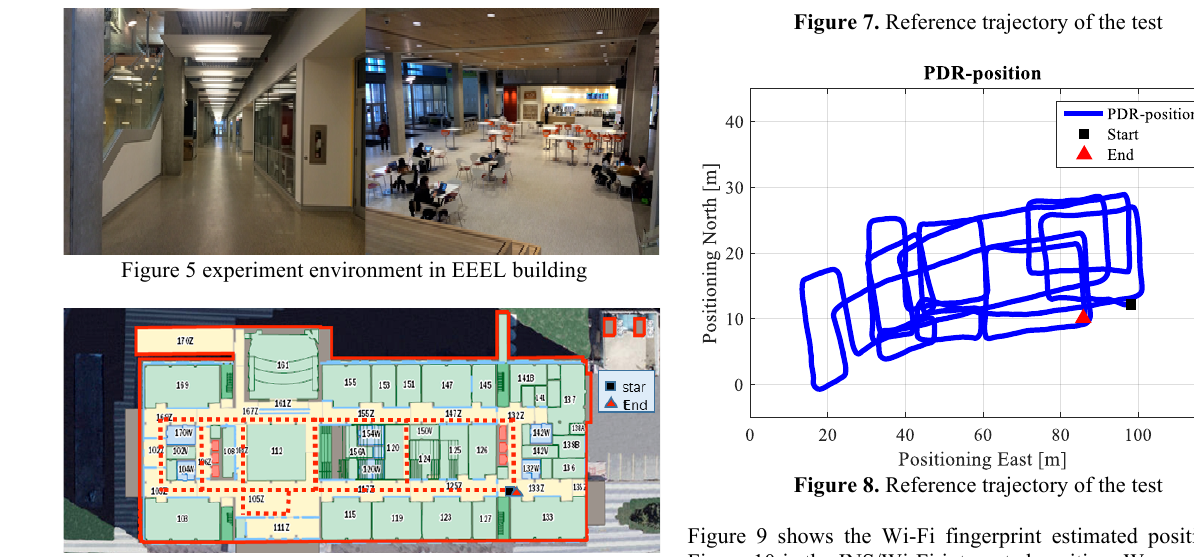
Figure 6 Designed trajectory for the test Table 1 ． Sensors of Samsung S4